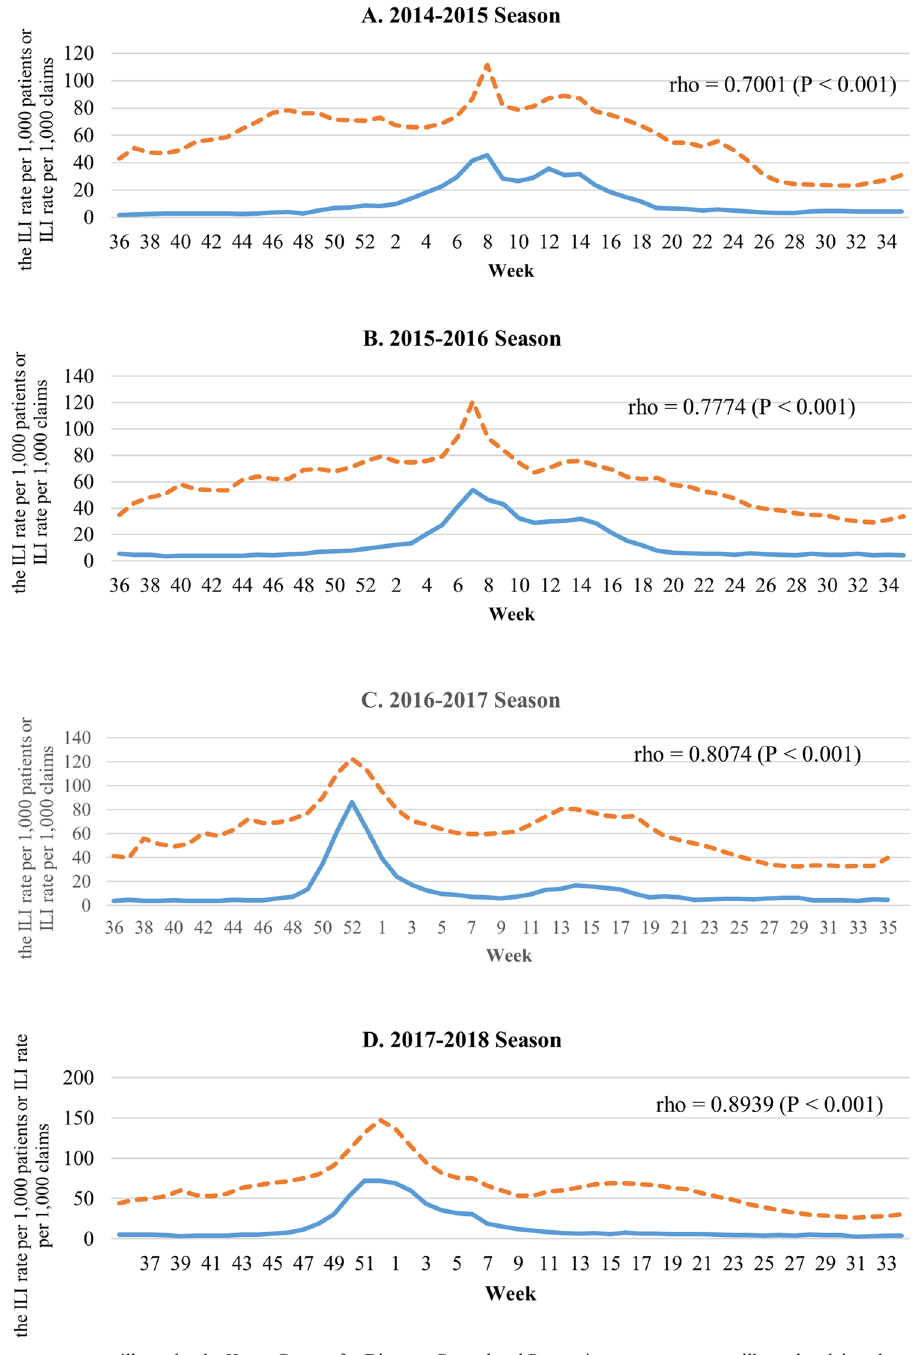
Figure 2. (A) Comparison of the ILI-related claims rate and clinical sentinel surveillance report, 2014–2015 season. (B) Comparison of the ILI-related claims rate and clinical sentinel surveillance report, 2015–2016 season. (C) Comparison of the ILI-related claims rate and clinical sentinel surveillance report, 2016–2017 season. (D) Comparison of the ILI-related claims rate and clinical sentinel surveillance report, 2017–2018